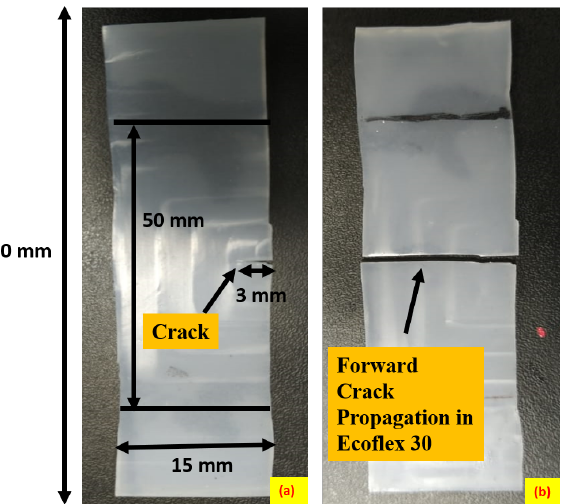
Figure 4. Representation of forward crack propagation of Ecoflex 30 of thickness 3.6 mm at a strain rate of 40 mm/min; ( a ) initial cut in the specimen; ( b ) specimen after forward crack propagation.